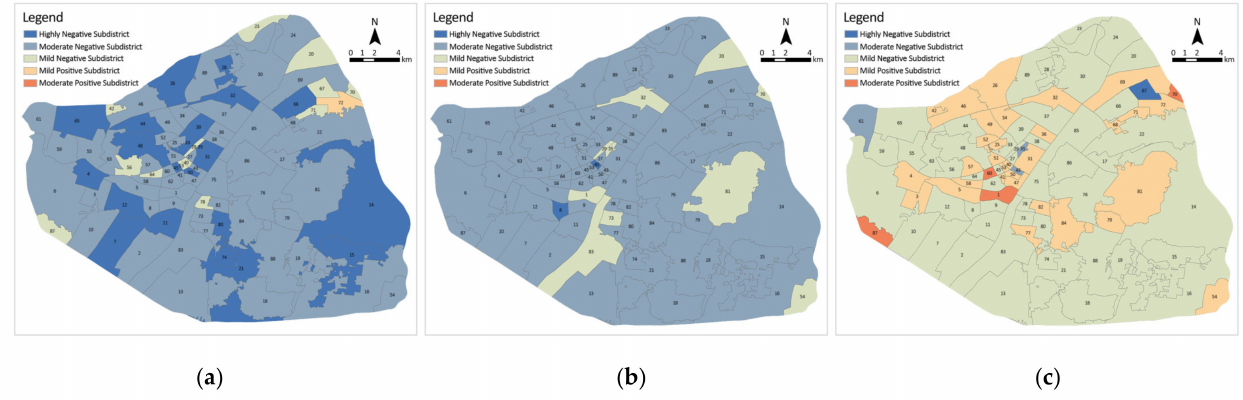
Figure 9. Distribution of sentimental values on a subdistrict scale: ( a ) Stage A; ( b ) Stage B; ( c ) Stage C.